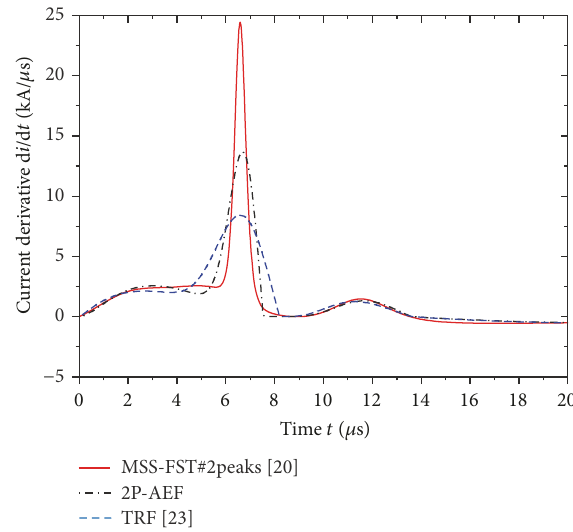
Figure 5: Derivatives of the assumed current waveshape [27], TRF [23], and 2P-AEF(2,1,2).